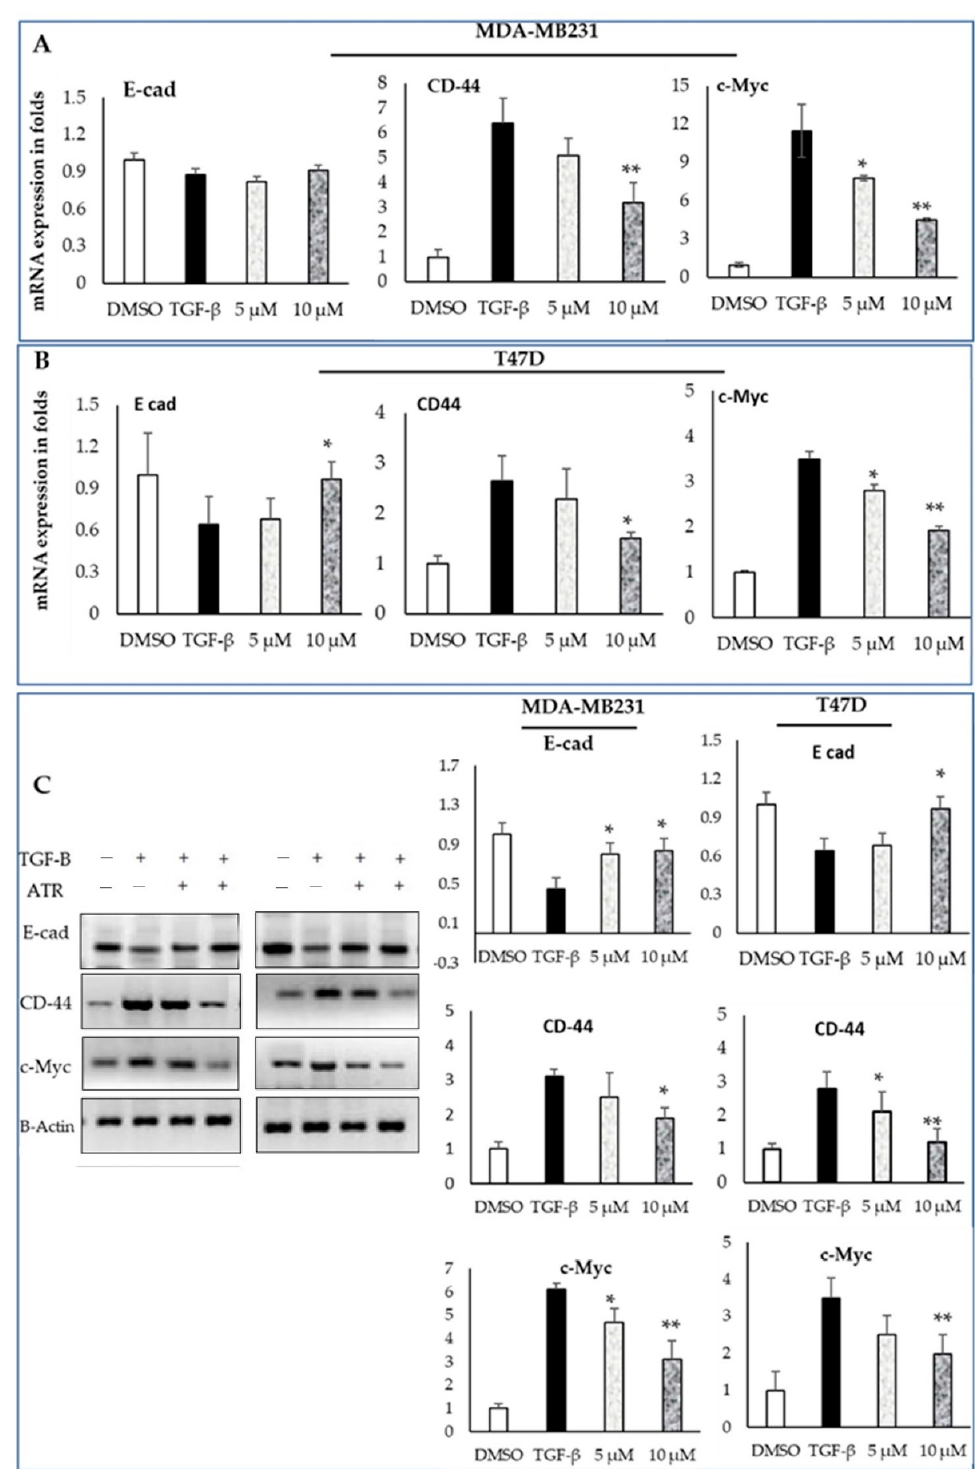
arrows indicate fibroblast-like cellular structures. Results are expressed as the mean ± SD of tripli- cate measurements.